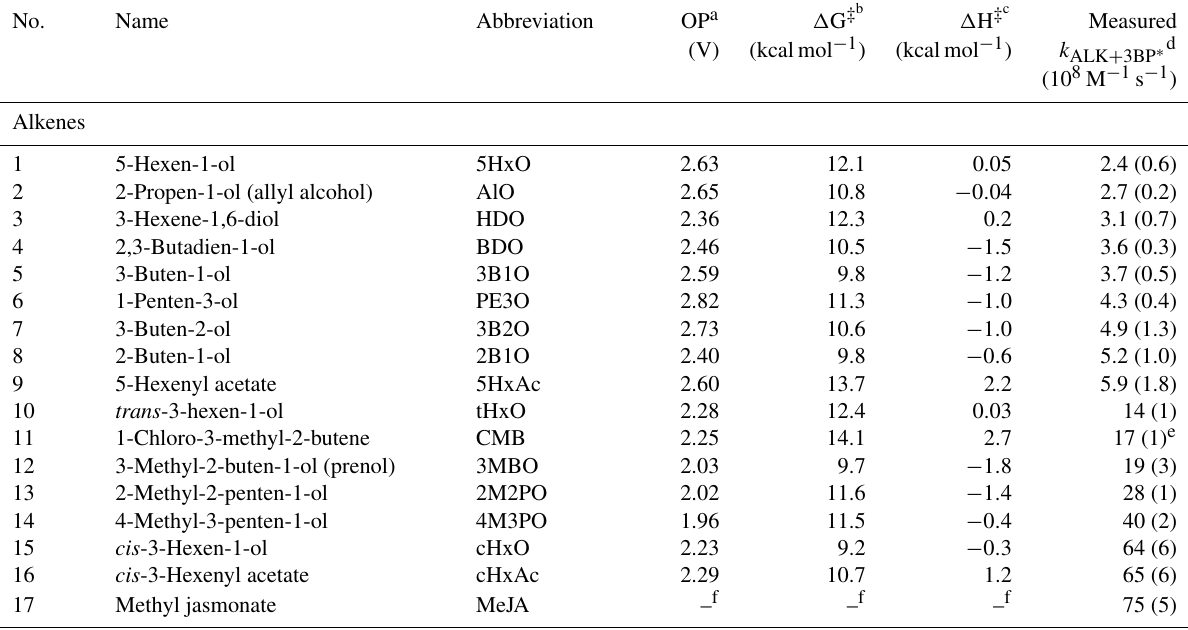
Table 1. Measured alkene–benzophenone triplet reaction rate constants, predicted OVOC–benzophenone triplet reaction rate constants, and computed parameters for the